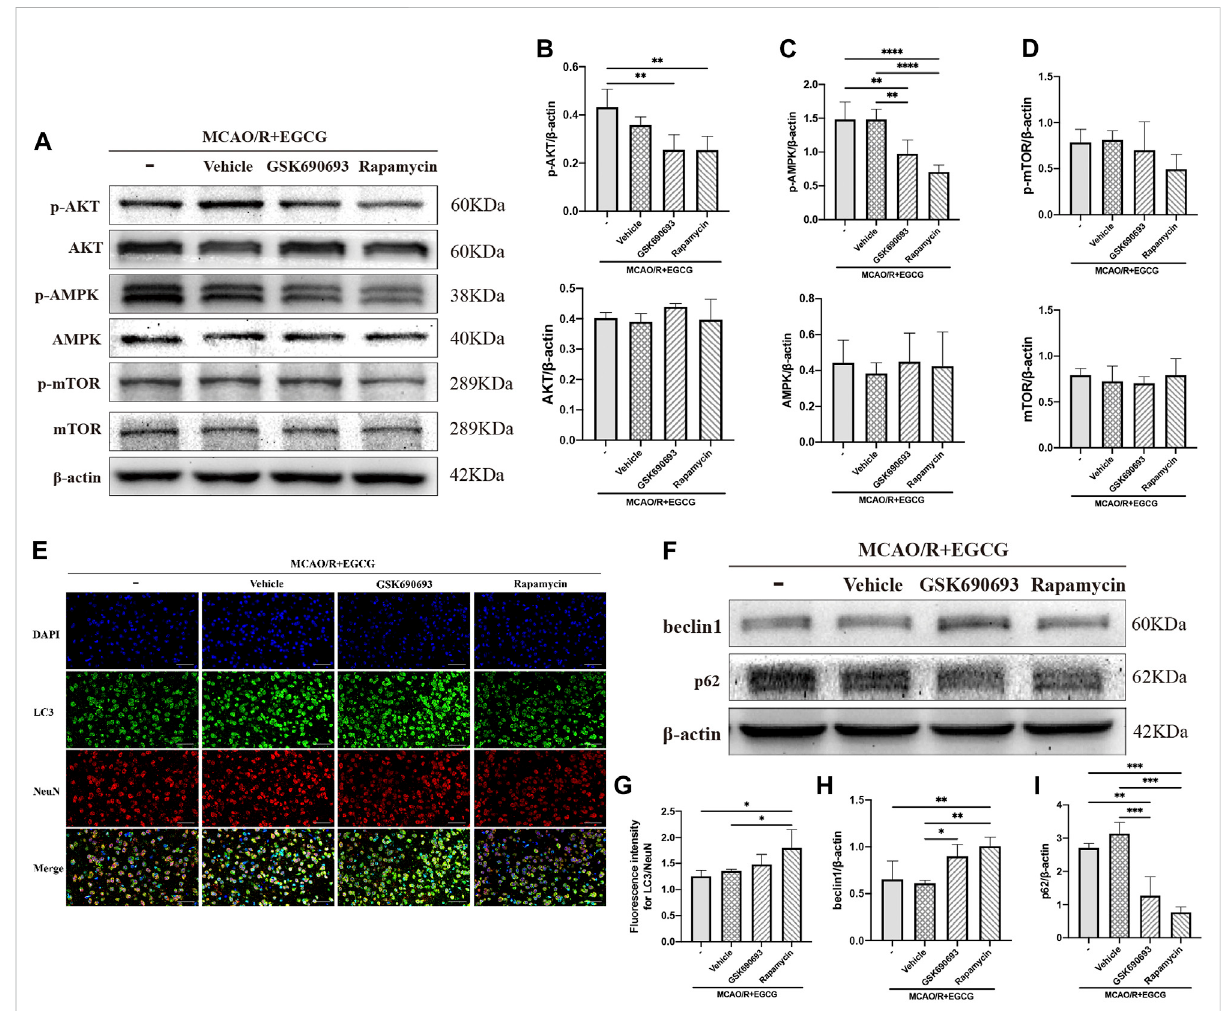
FIGURE 4 GSK690693andrapamycinreversedtheeffectofEGCGintheischemicbrainsofmiddlecerebralarteryocclusion/reperfusion(MCAO/R)mice. (A) The expression of p-AKT and AKT (B) , p-AMPK and AMPK (C) , p-mTOR and mTOR (D) was assessed by Western blotting assay. (E,G) The expression of LC3 was detected by immuno fl uorescent staining assay. Data were shown in the cortical penumbra area from the ipsilateral side of surgery on post-surgery day (PSD) 1. (F) The expression of beclin1 (H) and p62 (I) was assessed by Western blotting assay (scale bar = 20 μ m). Each experimental datum was presented as mean ± standard deviation ( n = 3 animals per group). * p < 0.05, ** p < 0.01, *** p < 0.001, **** p < 0.0001 versus the speci fi ed